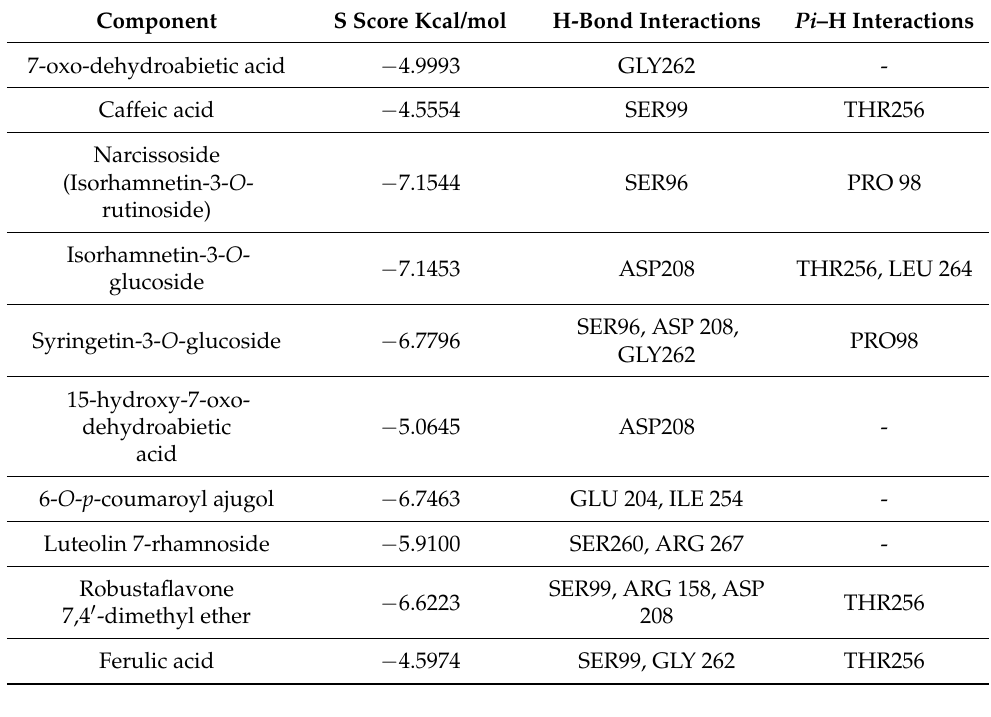
Table 5. Docking details of the selected components of ARBE on P53.